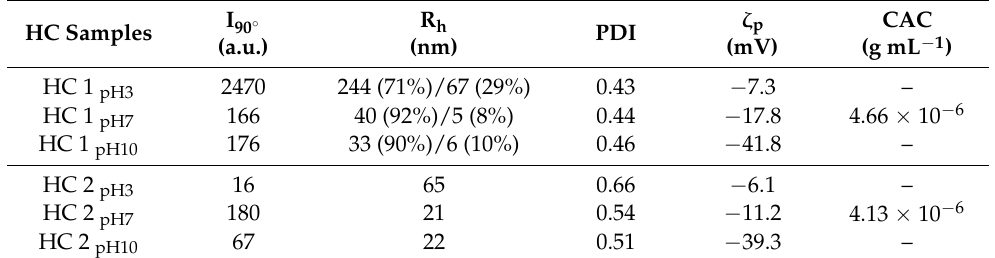
Table 2. DLS and ELS results for HCs in aqueous media in varying pH solutions. HC Samples